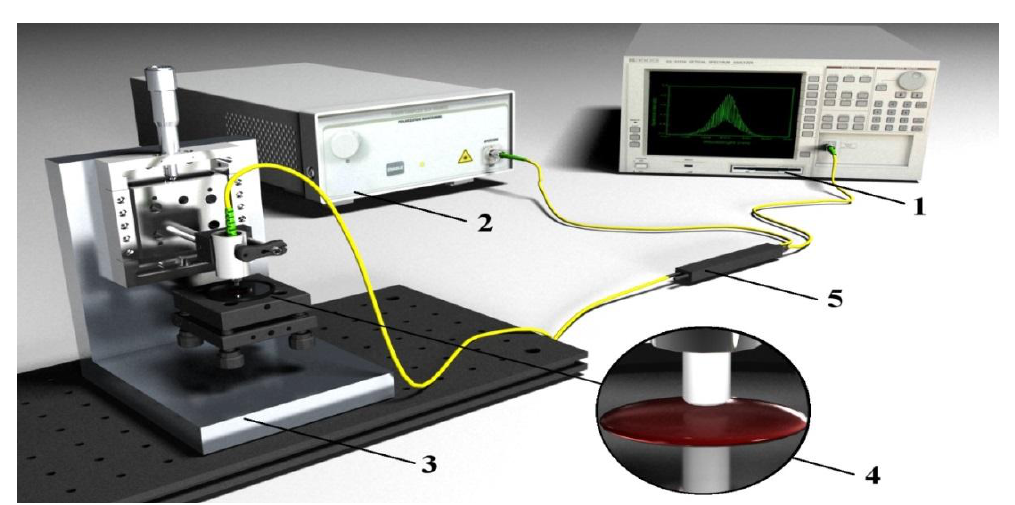
Figure 2. The experimental set-up: ( 1 ) optical spectrum analyzer; ( 2 ) superluminescent diode; ( 3 ) micro-mechanical stage; ( 4 ) Fabry-Perot interferometer; ( 5 ) fiber-optic